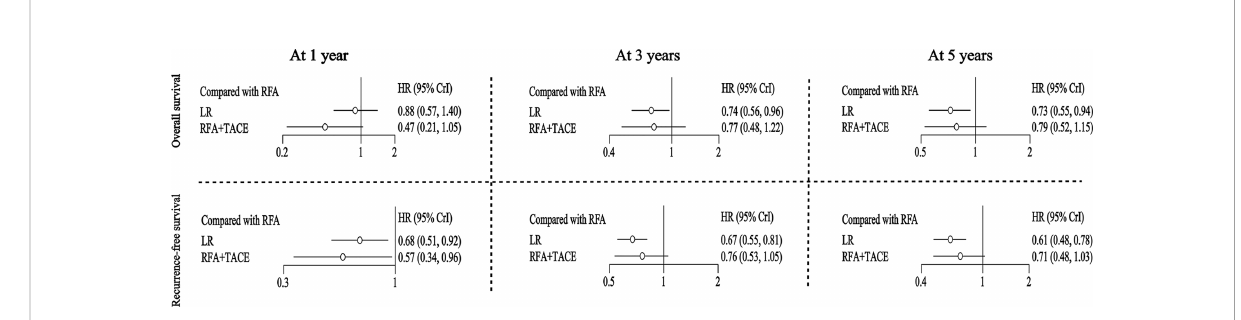
FIGURE 2 Hazard ratios (for OS and RFS) along with 95% con fi dence intervals (CIs) for LR and RFA+TACE compared with RFA for all the included